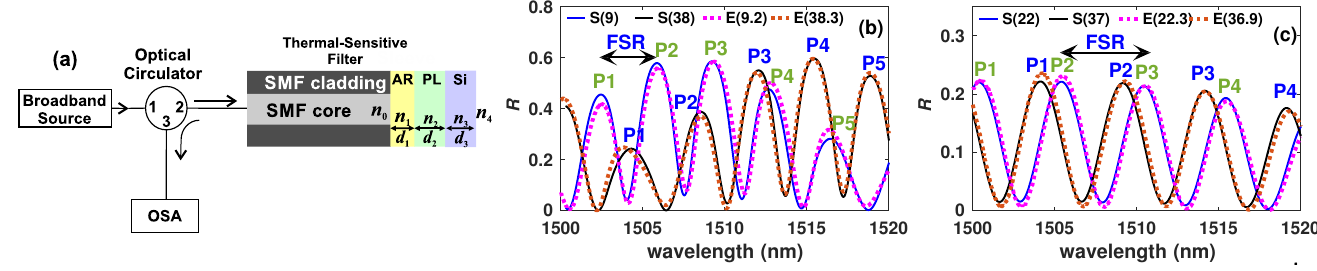
Figure 1. ( a ) Sensing arrangement and the interferometric filter head; simulated (S) and measured (E) reflected intensity distribution spectra of ( b ) sensor 1 and ( c ) sensor 2 at different